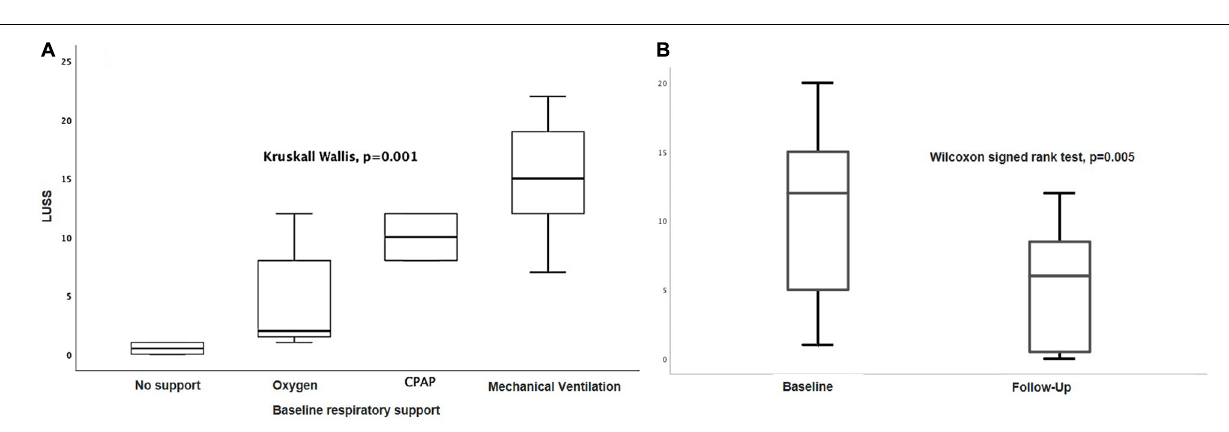
FIGURE 3 | (A) LUSS median differences between levels of pulmonary support (Kruskal–Wallis, p = 0.001). (B) Median difference of baseline and follow-up LUSS (Wilcoxon signed-rank test, p =